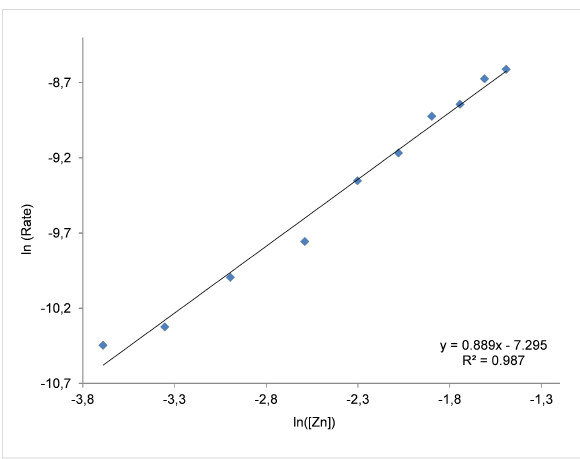
Figure 4: Double logarithmic plot to determine the order in binary cata- lyst Zn(salphen) 1 /NBu 4 I in the presence of a (small) excess of NBu 4 I. Conditions: 1,2-epoxyhexane (10 mmol) as substrate, 30 °C, 1 MPa of CO 2 , 2 h, [Zn] = 0.025–0.225 mol % and [NBu 4 I] = 0.4 mol %. For the steady state domain using two different concentrations of binary cata- lyst please refer to Supporting Information File 1, Figure S5.